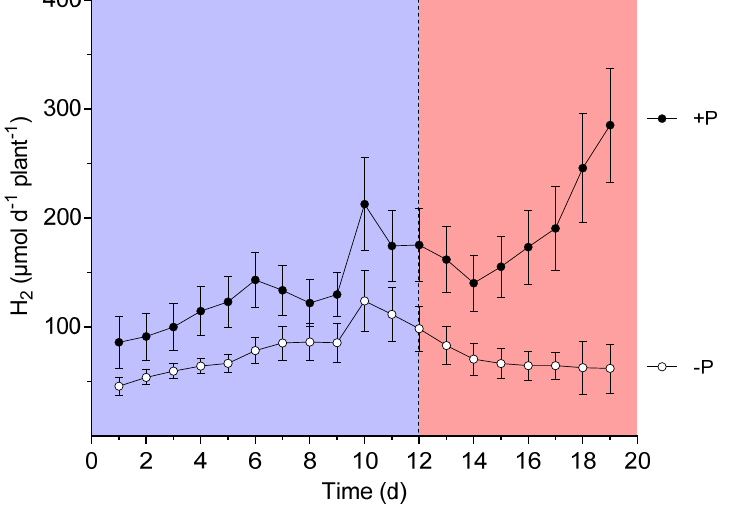
Figure 2. Apparent nitrogenase activity (ANA) of M . truncatula sunn plants grown at sufficient P supply (+P) and during P depletion ( − P). Data are given as means of six replicates ± SE. Each point represent the integral of the amount of H every five minutes over a 24 h period. The dotted line indicates the point in time when treatments began to differ significantly in ANA ( t -test, p < 0.05). The colors distinguish the period of significantly different ANA (reddish) from the period of P depletion but not yet different H evolution (blue). 2